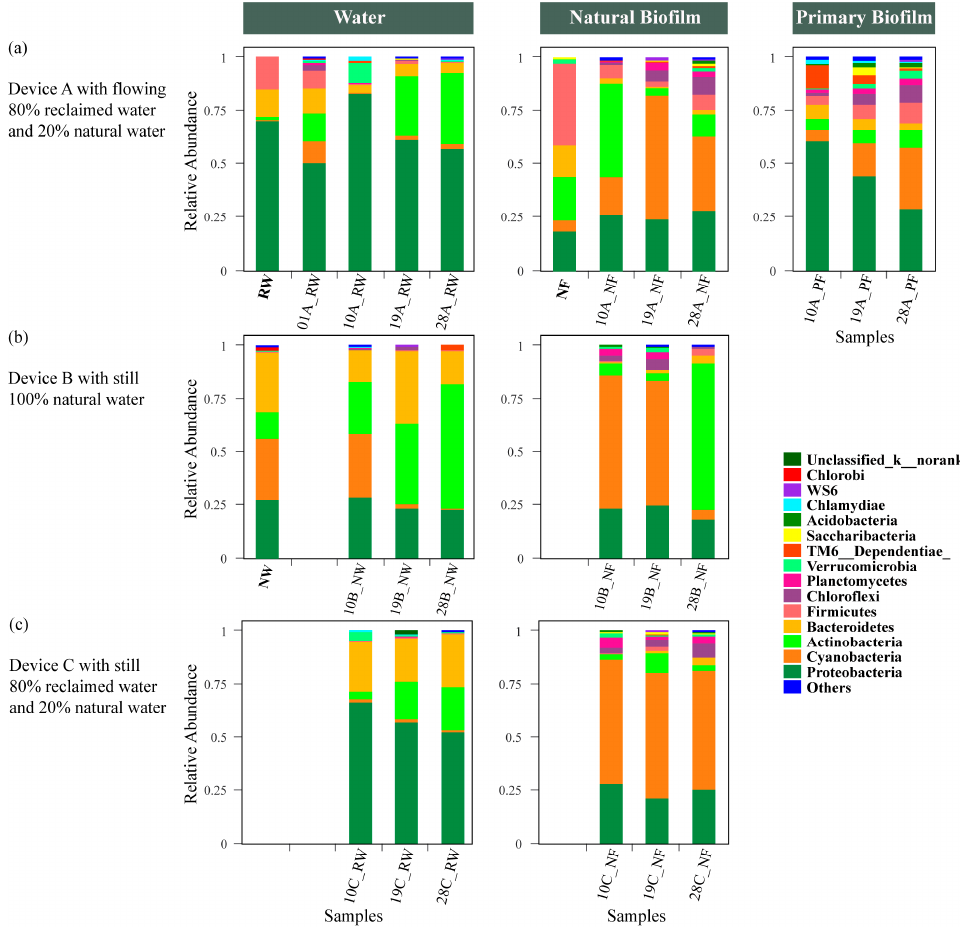
Figure 4. Composition of bacterial community structure. ( a ) Device A with flowing 80% reclaimed water and 20% natural water; ( b ) device B with still 100% natural water; ( c ) device C with still 80% reclaimed water and 20% natural water.